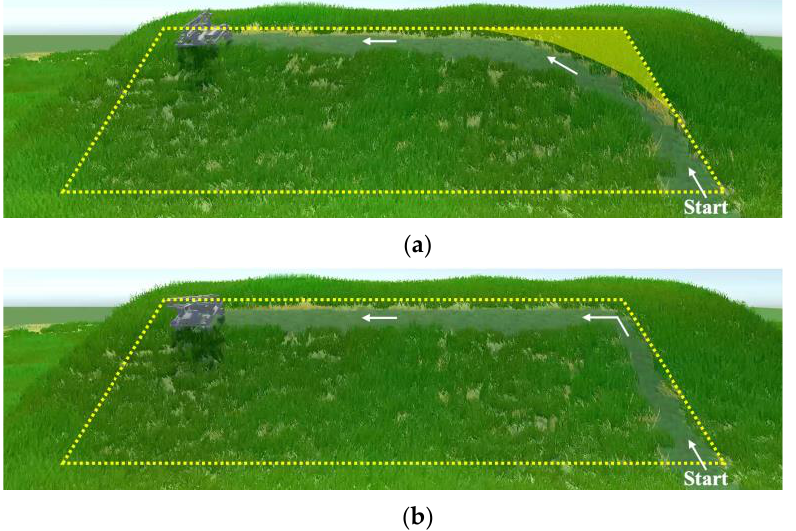
Figure 5. Grass cutting simulation. The inside yellow dotted line and lined arrow represent the target area and the robot moving direction, respectively. ( a ) Case 1: robot without a 90° direction change. ( b ) Case 2: robot with a 90° direction change.